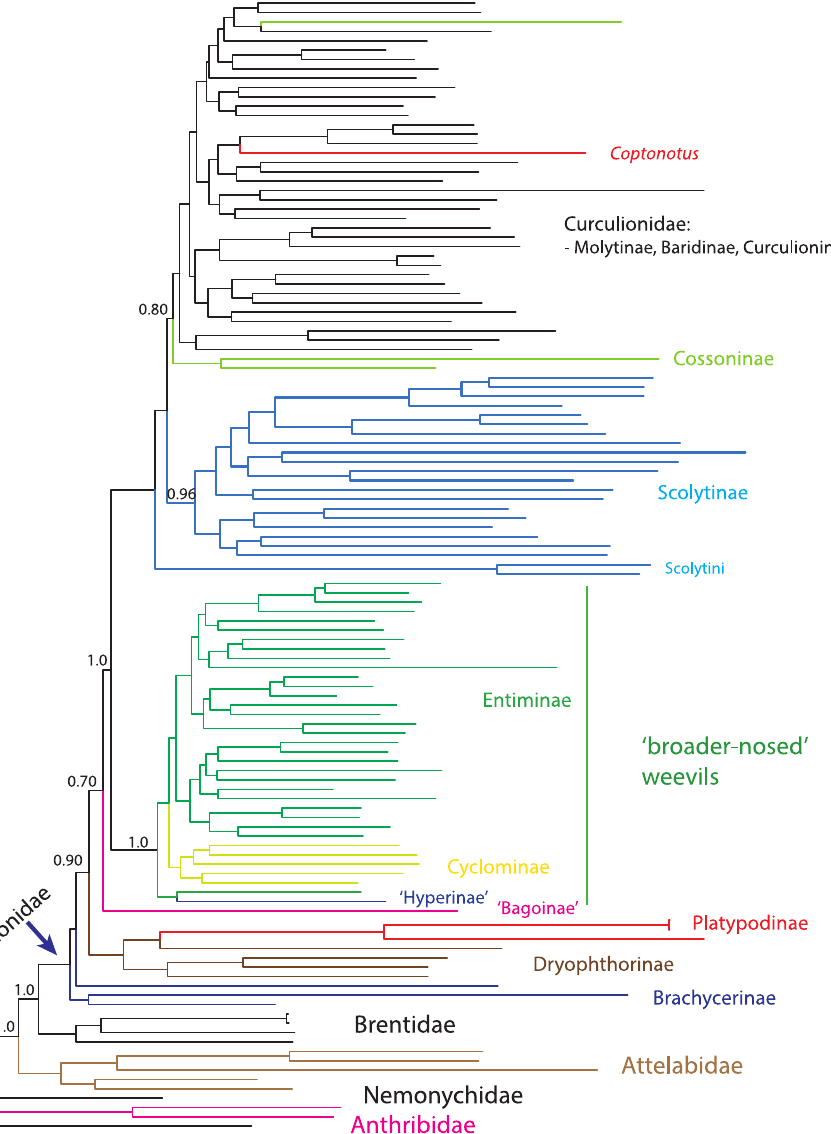
Figure 2. Mitochondrial genome phylogeny redrawn from Gillett et al. (2014), with various families and subfamilies marked in different colours. Node support values are posterior probabilities